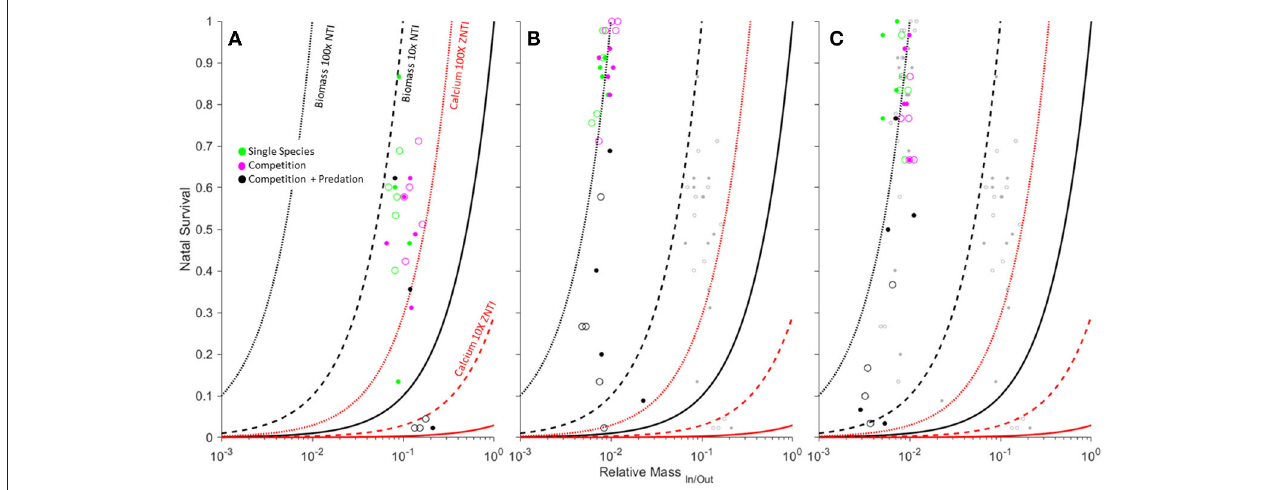
FIGURE 3 | Effects of competition, predation and light levels (low [open] vs. high [filled]) on biomass and calcium transfer magnitude for Anaxyrus americanus (A) , Hyla versicolor (B) , and Lithobates sphenocephalus (C) . Data points represent mesocosm average relative mass of ova/metamorphs ( RM ) and larval survivorship ( N Out / In ) from a previous study ( Luhring, 2013). Zero net transfer isoclines for biomass (solid black), and Ca (solid red) and their 10x and 100x net transfer isoclines (dashed and dotted NTI’s) are shown for reference. Each panel includes the data from panels to their left as gray dots for reference.